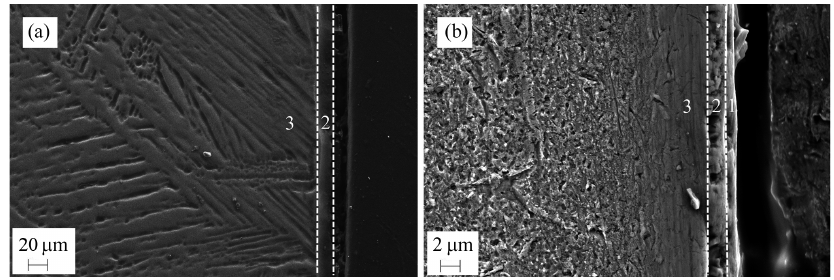
Figure 2: Cross-section SEM micrographs of (a) Nit.700 sample and (b) Nit.700 + CrN sample: (1) CrN film, (2) compound layer, and (3) diffusion layer.